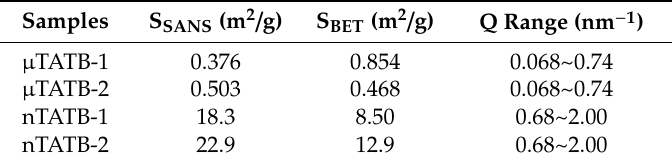
Table 1. Comparison of the surface area measurements respectively by small angle neutron scattering (SANS) and Brunauer-Emmett-Teller (BET) of four representative samples.